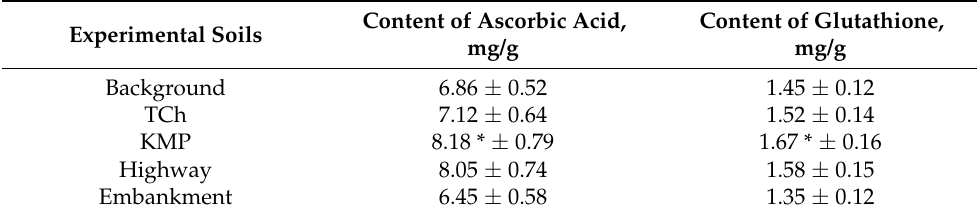
Table 4. Effect of the polyelemental pollution of soils on the content of ascorbic acid and glutathione in Echinochloa frumentacea shoots.